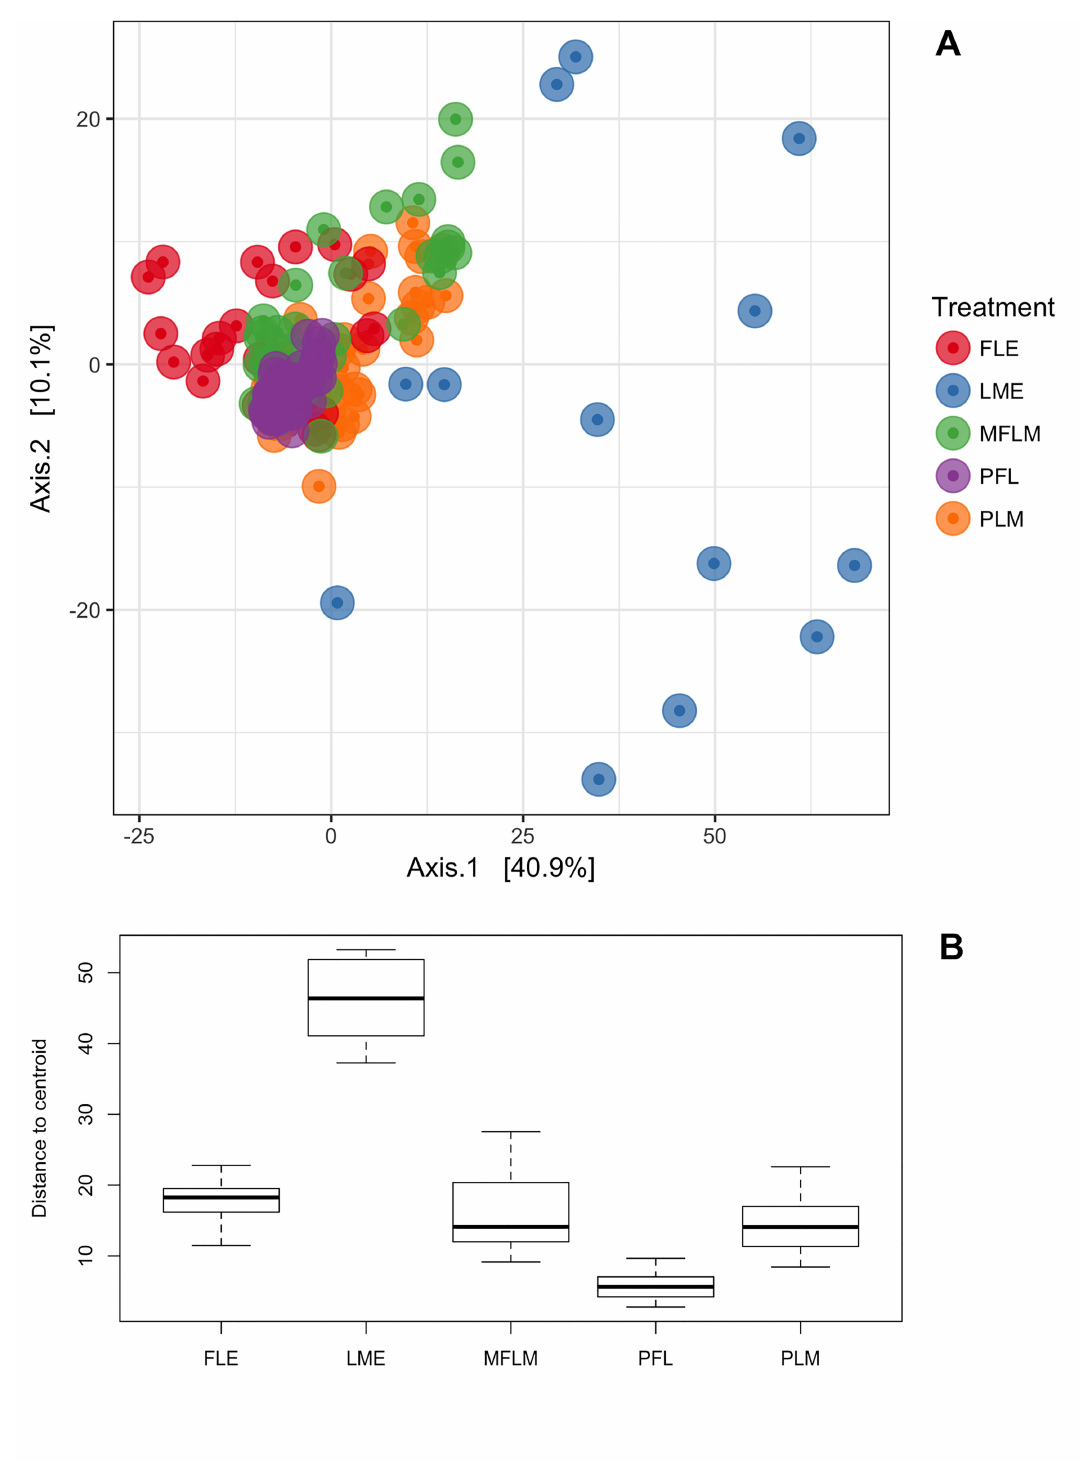
Fig 1. Beta diversity comparisons among microbial communities. A and B. Graph A represents clusters of microbial communities. Each point represents an individual sample, with colors indicating feeding treatments. Graph B represents measurement of multivariate dispersion for each treatment. FLE = exclusive formula; LME = exclusive own mother´s milk; MFLM = 50% formula and 50% own mother’s milk; PFL = � 70% formula; PLM = � 70% own mother’s milk.